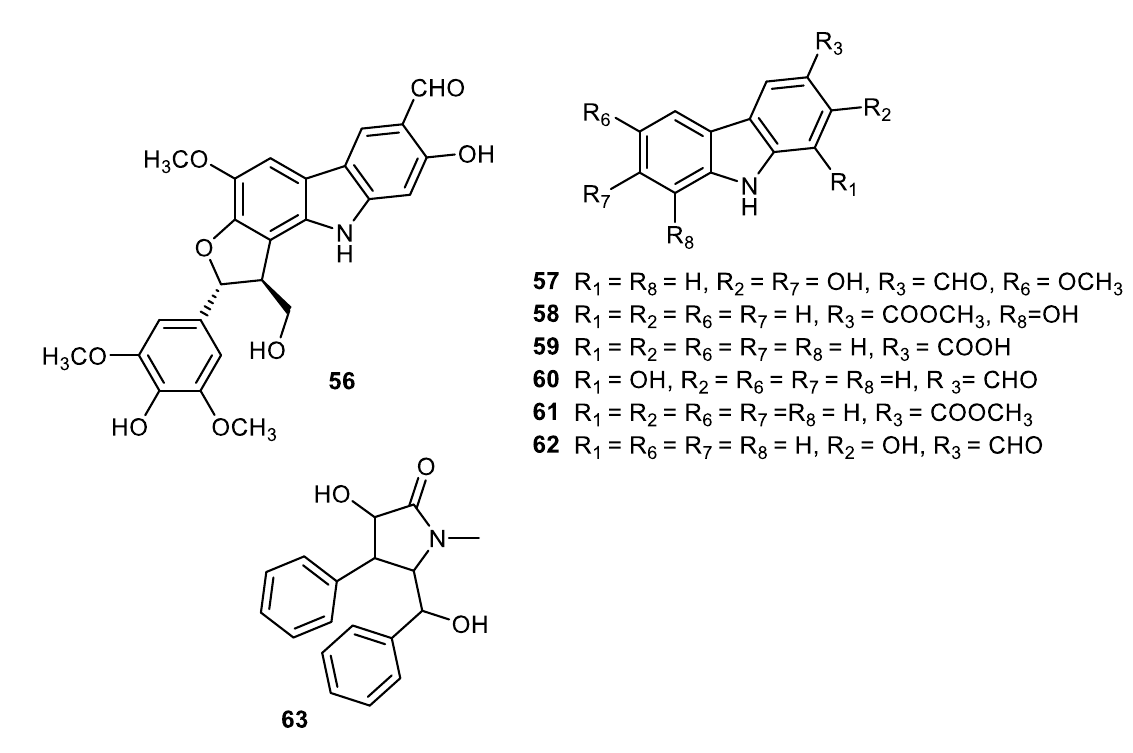
Figure 9. Structures of alkaloids 56 – 63 .